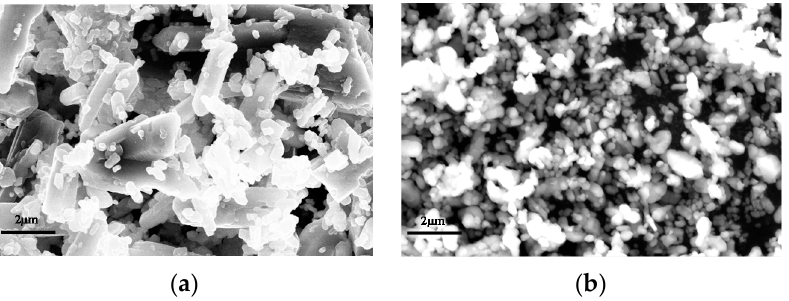
Figure 4. The SEM micrograph of two different raw material SrCO 3 powders: ( a ) coarse-particle SrCO 3 , ( b ) fine-particle SrCO 3 .